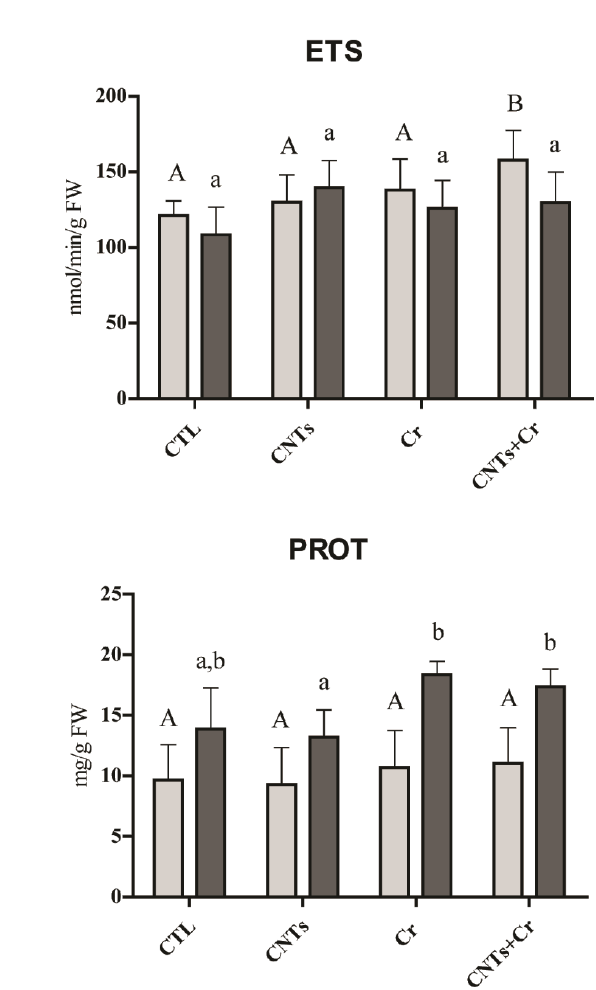
Figure 1. ( A ) Electron transport system (ETS) activity; ( B ) protein (PROT) content (mean values + standard deviation), in Ruditapes decussatus (light gray bars) and Ruditapes philippinarum (dark gray bars) after a 28-day exposure period. For each species, tested treatments were: control (CTL), carbon nanotubes (CNTs), chromium (Cr), and the combination of both contaminants (CNTs + Cr). Signif- icant differences ( p < 0.05) among treatments are represented with different letters (lowercase for R.